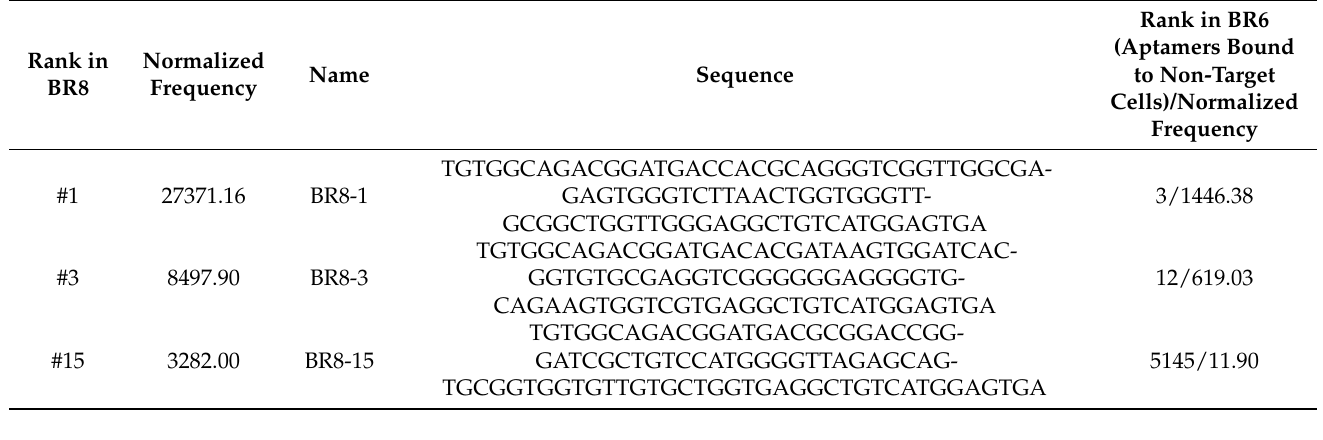
Table 1. Selected aptamer sequences from the top ten enriched sequences showing their ranking and normalized frequency in BR8 and BR6.